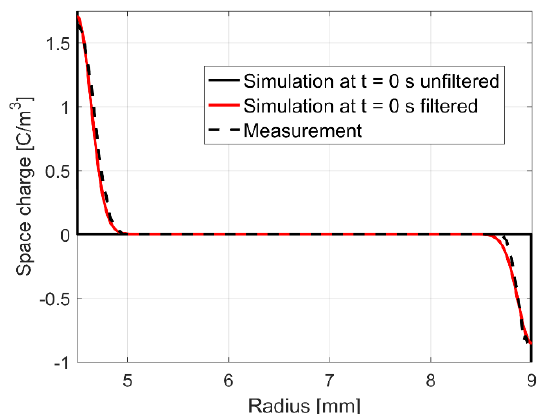
Figure 17. Comparison of measurements against filtered and unfiltered simulation results at t ≈ 0 s. [14,95].